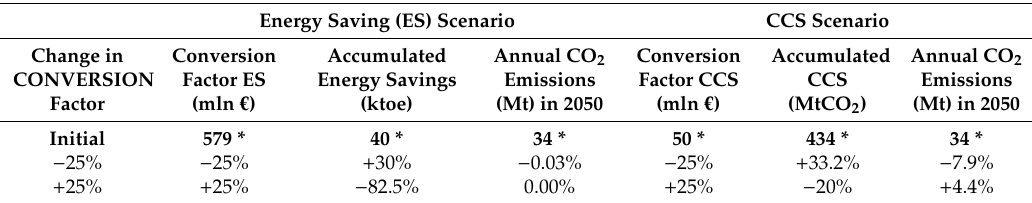
Table 8. Sensitivity analysis on conversion factor